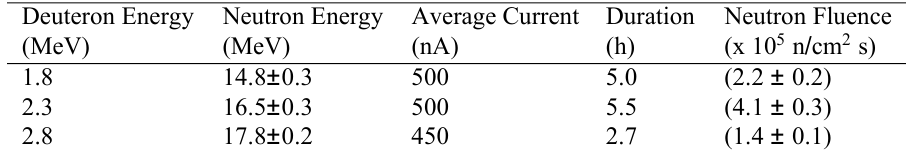
Table 1. Main quantities concerning the irradiations.